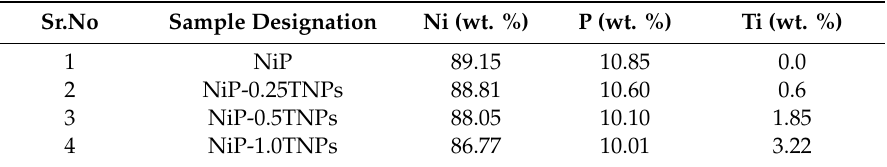
Figure 4. Energy dispersive spectroscopy (EDX) scan spectra of ( a ) NiP, ( b ) NiP-0.25TNPs, ( c ) NiP- 0.5TNPs and ( d ) NiP-1.0TNPs nanocomposite coatings.